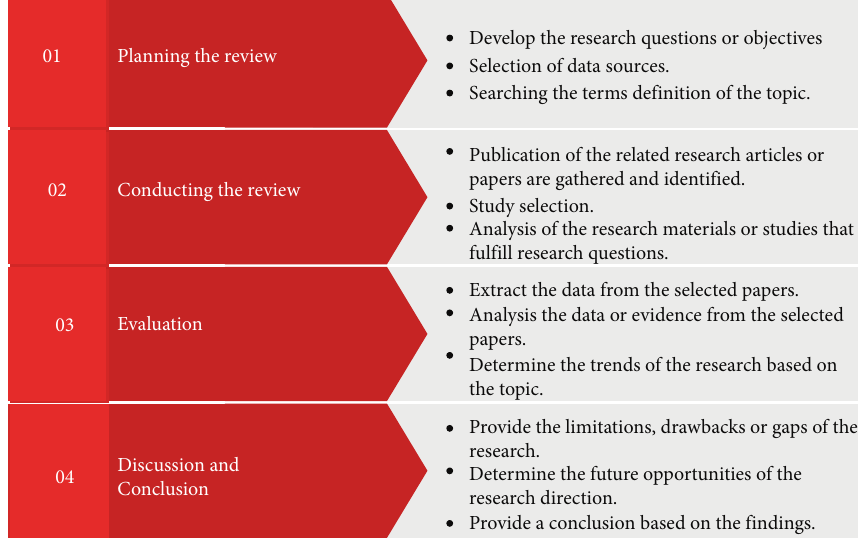
Figure 1: Process of the systematic literature review for this